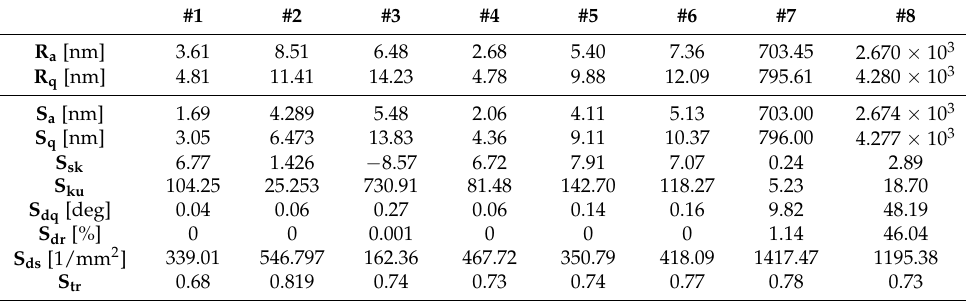
Table 3. Linear and areal roughness parameters of the obtained